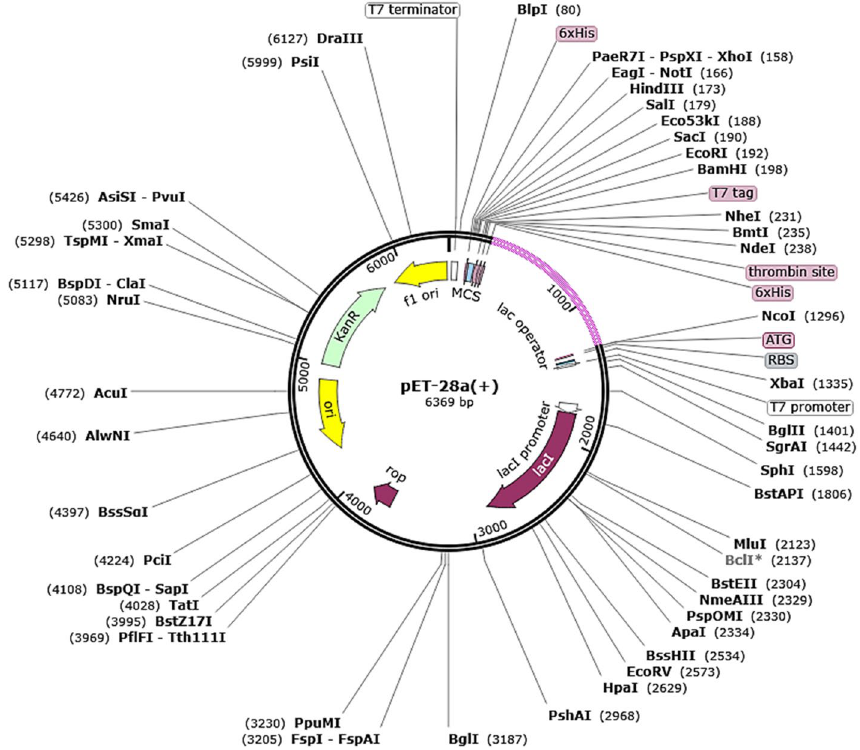
Figure 9. Cloned vaccine (shown in magenta color) into pET-281(+) vector.